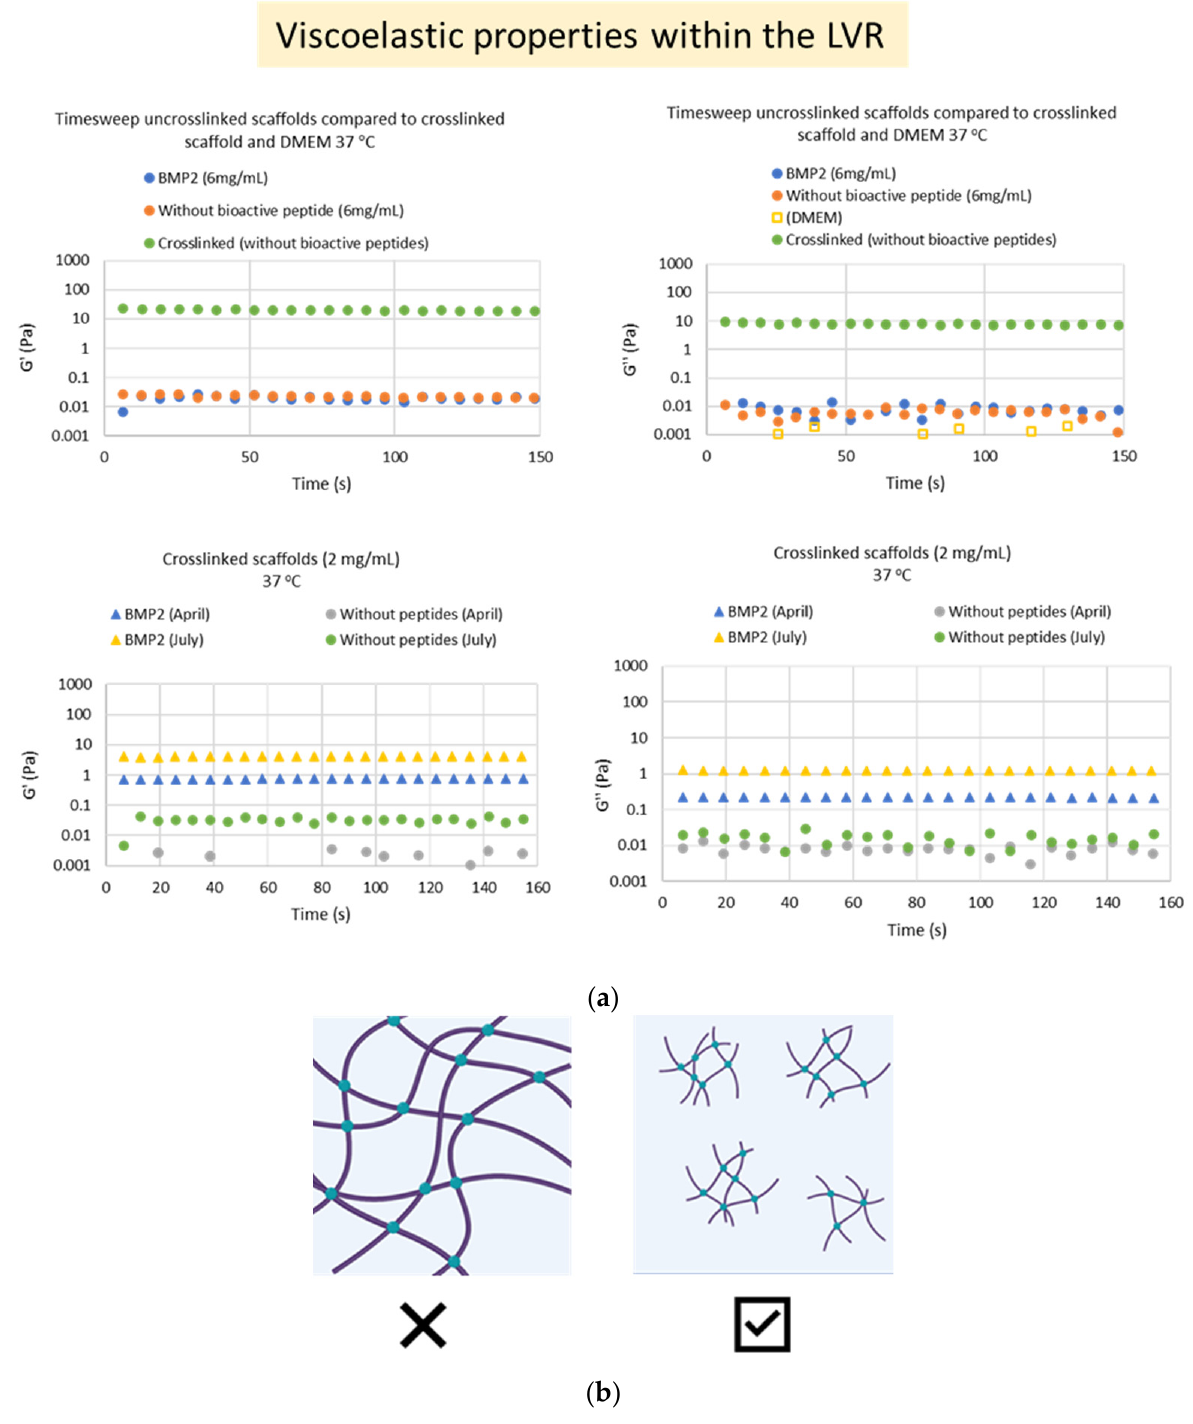
Figure 5. The viscoelastic properties of the crosslinked and uncrosslinked biomaterials, as measured within the LVR (at 3% strain). ( a ): Plots of elastic modulus (G ′ ) and viscous modulus (G ″ ) of the biomaterials, as a function of time (s) at 37 °C. “BMP2”: scaffold-BMP2, “without peptides”: scaffold without peptides, “Apr”: April 2022 measurements, “Jul”: July 2022 measurements. All data correspond to different aliquots of the same samples in order to avoid preshearing effects or different sample preparations in order to show reproducibility. ( b ): Schematic representation of the possible form of the scaffolds in DMEM at 37 °C, as islands of similar 3D networks instead of a continuous network. Created with BioRender.com.